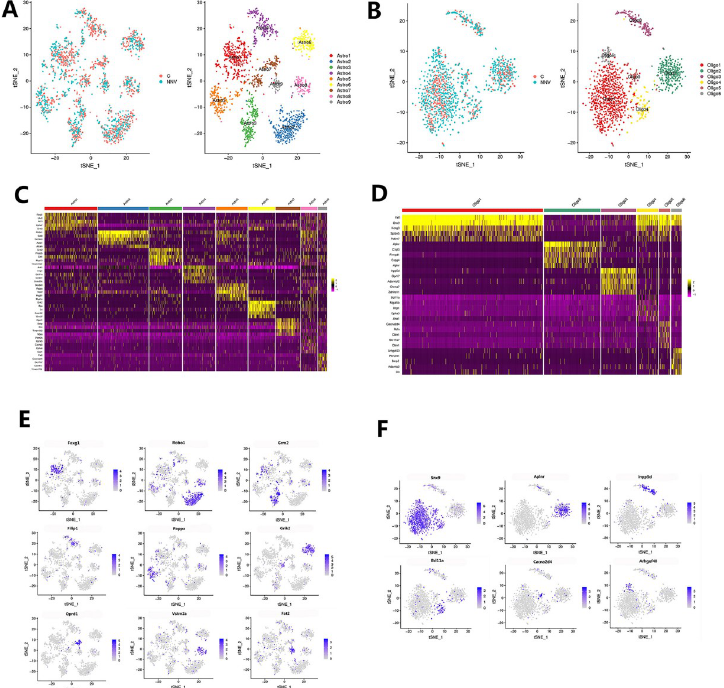
Fig 4. Astrocyte and oligodendrocyte subtypes in the midbrain. (A) The tSNE plot showing the nine astrocyte subtypes identified in the midbrain. Different astrocyte subtypes are color coded. (B) The tSNE plot showing the six oligodendrocyte subtypes in the midbrain. Different oligodendrocyte subtypes are color coded. (C) Heat map of the top five markers for the nine astrocyte subtype clusters. (D) Heat map of the top five markers for the six oligodendrocytes subtype clusters. (E) The tSNE plots showing the expression of representative marker genes are restricted to specific astrocyte clusters among all of the astrocyte subtype cells. The expression level is color coded. See also S4 Fig. (F) The tSNE plots showing the expression of representative marker genes are restricted to specific oligodendrocyte clusters among all of the oligodendrocyte subtype cells. The expression level is color coded. See also S5 Fig.